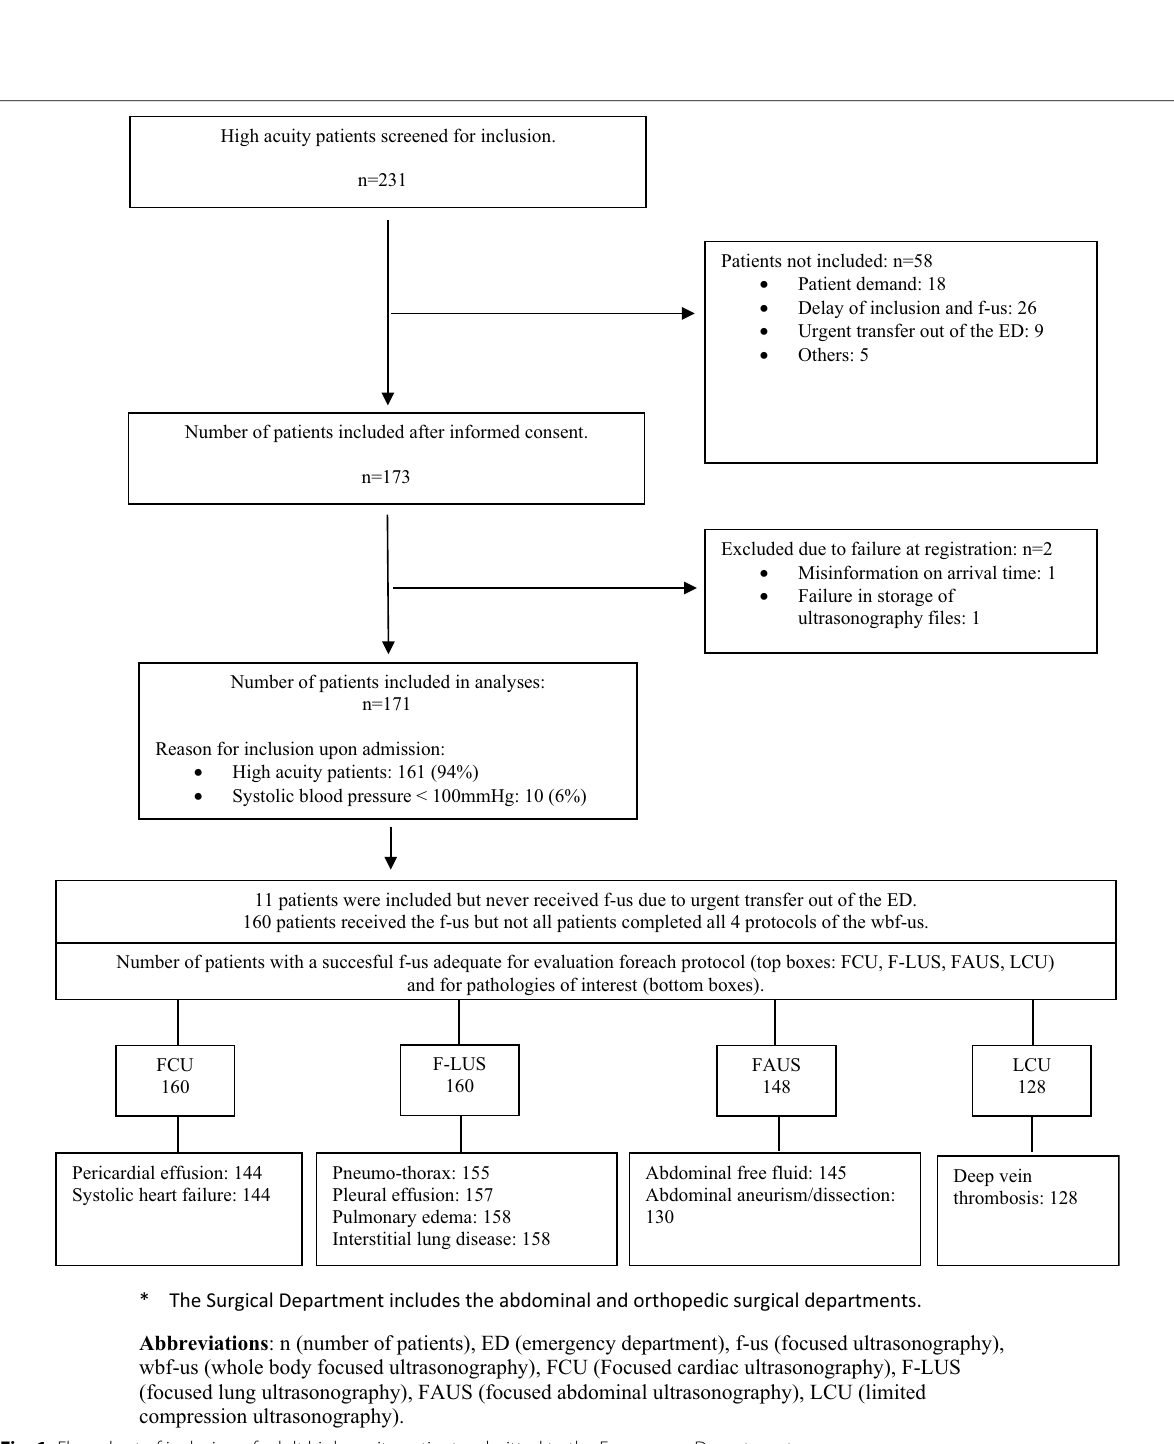
The most frequent specific pathological findings were pleural effusion n 39, interstitial syndrome/pulmonary = edema n 25 and systolic heart failure n 19. For preva- = = lence of pathological wbf-us findings, see Table 2.